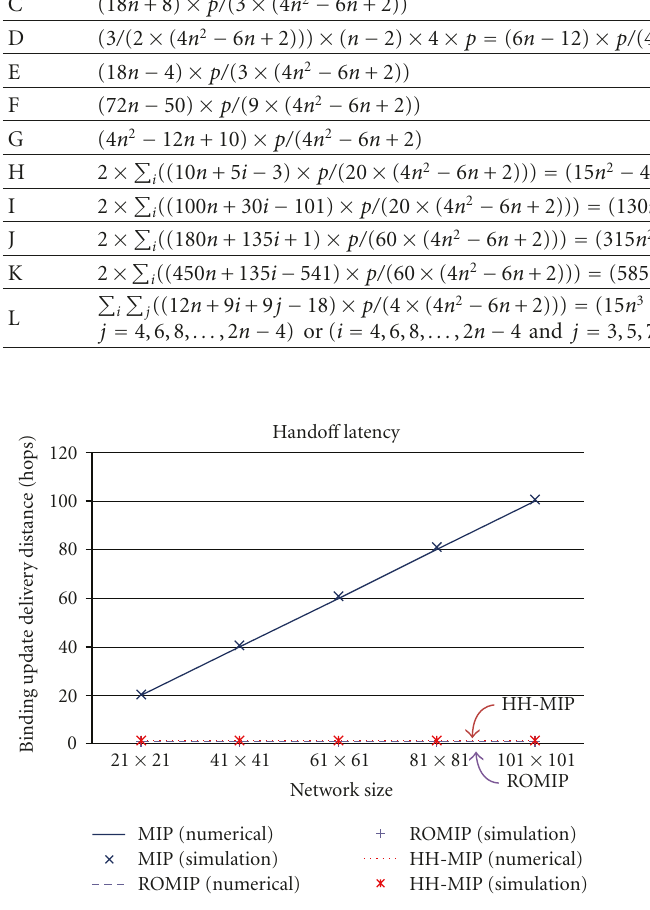
Figure 10: Comparison of hando ff latency between di ff erent approaches.